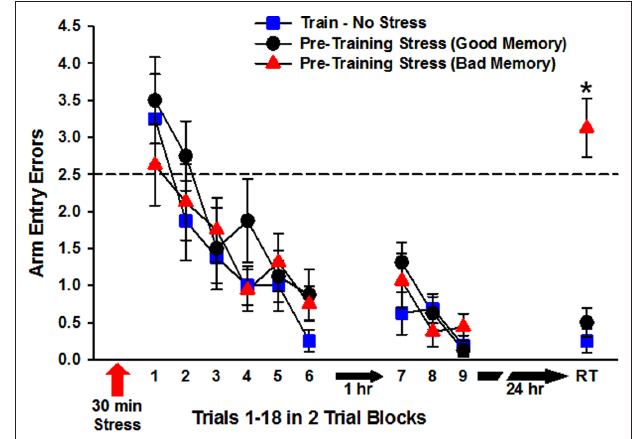
Figure 3 | radial-arm water maze performance during the first and second phases of training on Day 1 and on the long-term (24 h) memory test trial (rT; retention trial). The three groups of rats performed at a statistically equivalent level during trials 1–12 (blocks 1–6) and trials 13–18 (blocks 7–9). Rats exposed to predator stress prior to training were split into good (Pre-Training Stress, Good) and bad (Pre-Training Stress, Bad) memory subgroups based on the number of errors they committed on the RT. As illustrated in the figure, the Pre-Training Stress, Bad group exhibited impaired 24 h spatial memory, relative to both of the other groups. The dashed line a 2.5 arm entry errors indicates chance level of performance (Diamond et al., 1999). * p < 0.001 relative to the Standard Train and Pre-training Stress, Good memory groups (SNK post